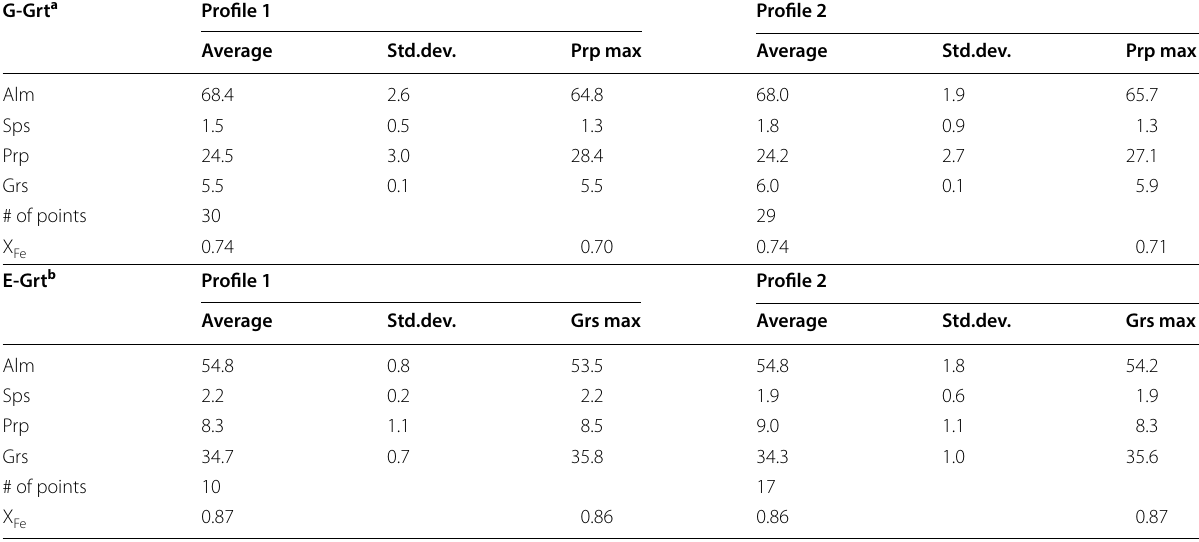
a Granulite facies garnet b Eclogite facies